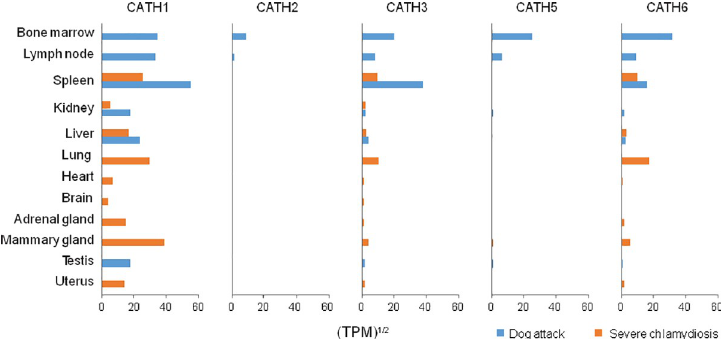
Fig 3. Expression of full-length koala cathelicidins in twelve tissue transcriptomes from two individuals [41,42]. Expressed as transcripts per million (TPM).